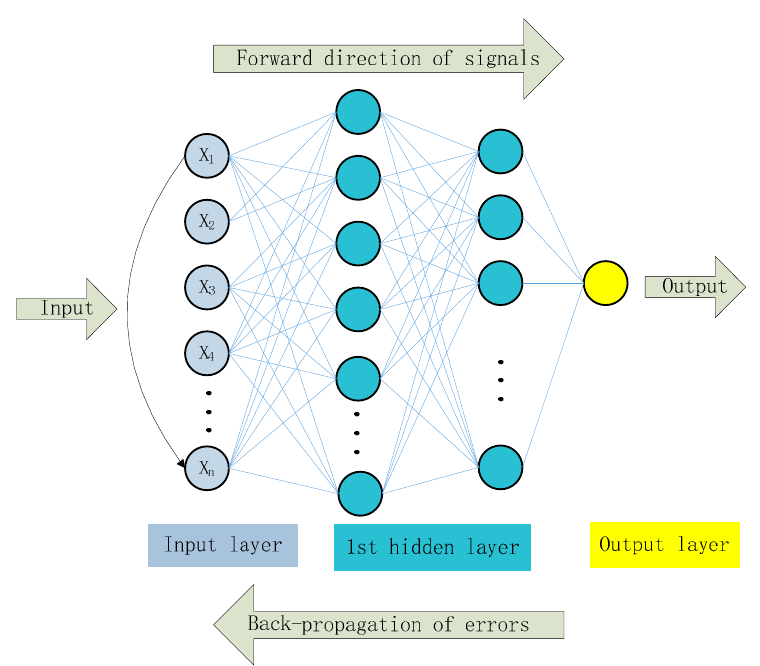
Figure 15. Schematic diagram of the BPNN structure of a multi-layer perceptron.